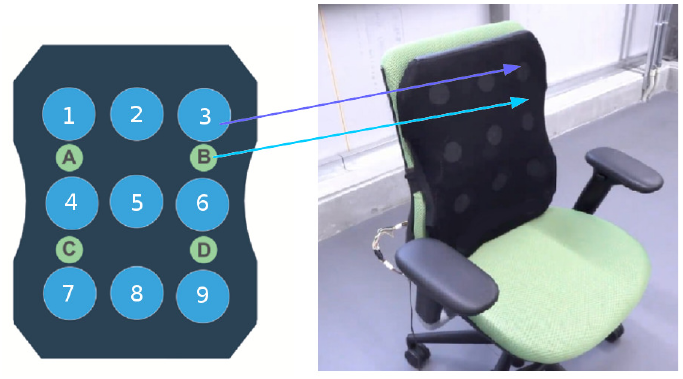
Figure 1. LifeChair pressure sensor arrangement ( i = 1...9) and vibration motor locations ( j = A ... D ).